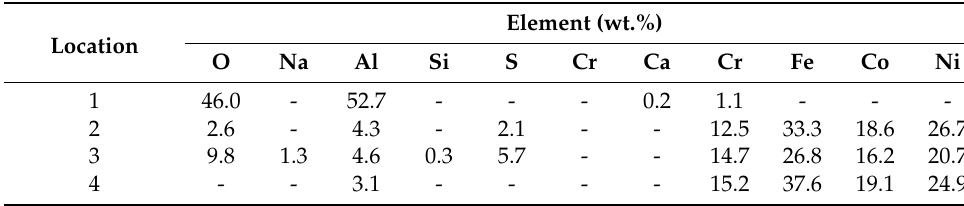
Figure 9. Elemental mapping of the Mo-HEA coating showing the extent of the discontinuous pas- sive film formed on the coating.